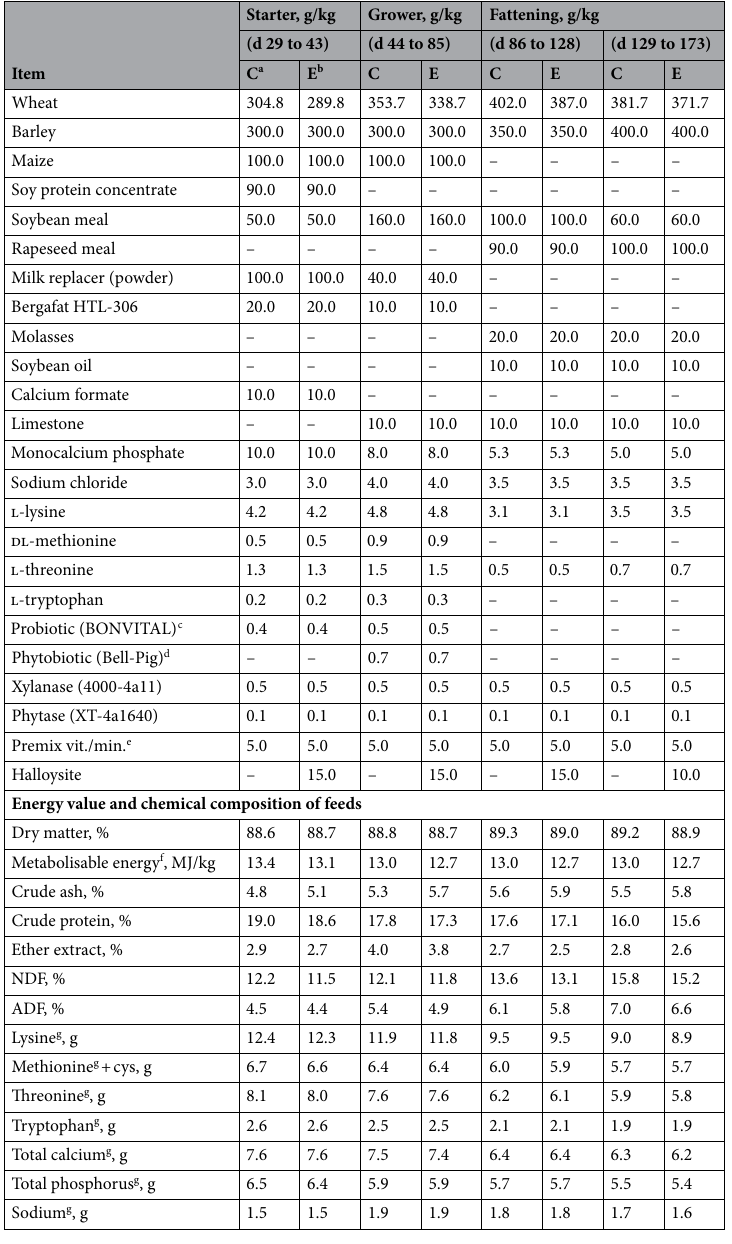
Table 1. Composition (g/kg) and nutritive value of experimental diets used in pig nutrition after weaning (29 days of life). a Control group fed complete mixtures without halloysite. b Experimental group fed complete mixtures with halloysite addition. c Product containing live lactic acid bacteria. d Product containing natural garlic and oregano extracts. e Mineral-vitamin feed additive adapted to the age of the pigs. f Calculated value according to European Table 14 as a sum of the ME content of components. g Calculated value from the chemical composition of raw